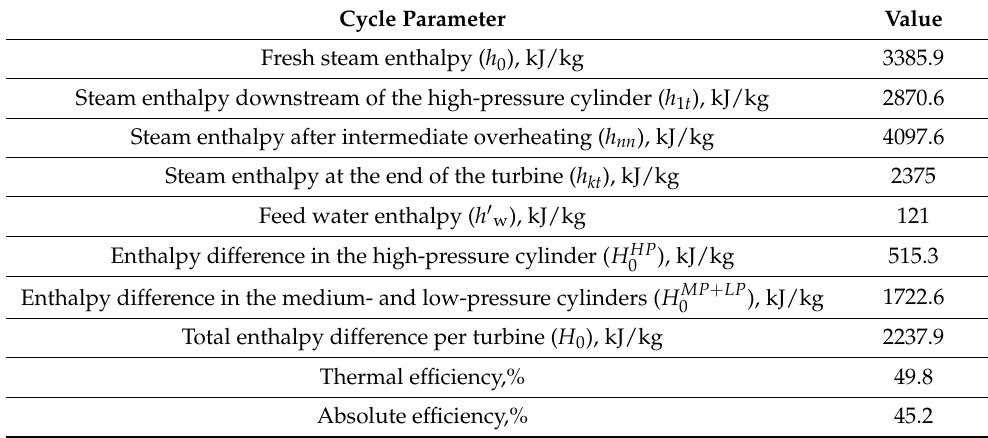
Table 7. Assessment of the cycle parameters when the temperature rises after intermediate overheating. Cycle Parameter Value Fresh steam enthalpy ( h 0 ), kJ/kg 3385.9 Steam enthalpy downstream of the high-pressure cylinder ( h 1 t ), kJ/kg 2870.6 Steam enthalpy after intermediate overheating ( h nn ), kJ/kg 4097.6 Steam enthalpy at the end of the turbine ( h kt ), kJ/kg 2375 Feed water enthalpy ( h (cid:48) w ), kJ/kg 121 Enthalpy difference in the high-pressure cylinder ( H HP ), kJ/kg 515.3 0 Enthalpy difference in the medium- and low-pressure cylinders ( H MP + LP ), 0